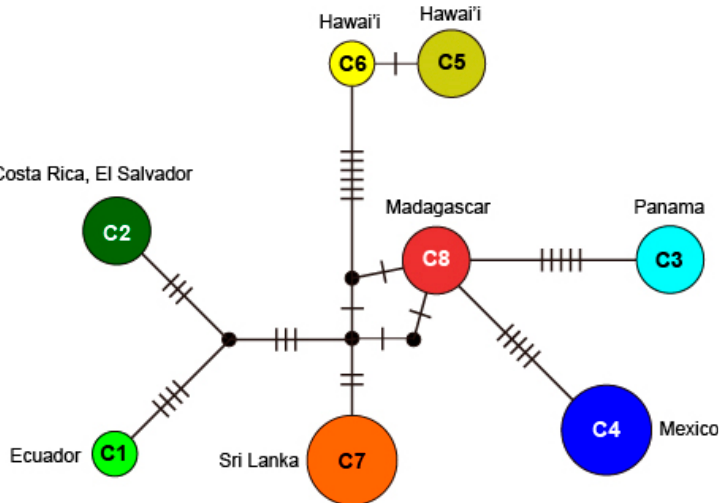
Figure 3. Haplotype network of G. sclerophyllum based on mitochondrial cox 1 sequences. Each circle denotes a single haplotype with size proportional to frequency. Each connecting line indicates one mutation step between haplotypes. Filled circle indicates inferred unsampled or extinct haplotypes. Each color represents different haplotypes.